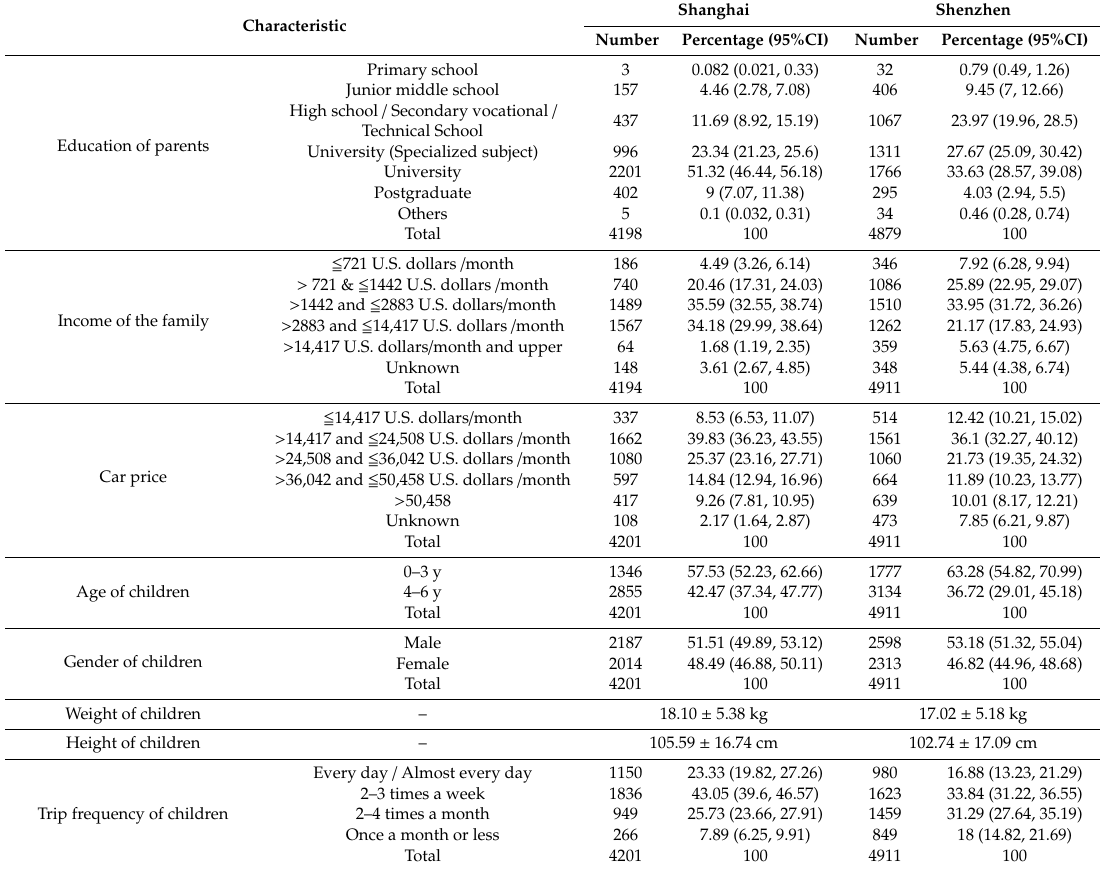
Table 1. Demographic